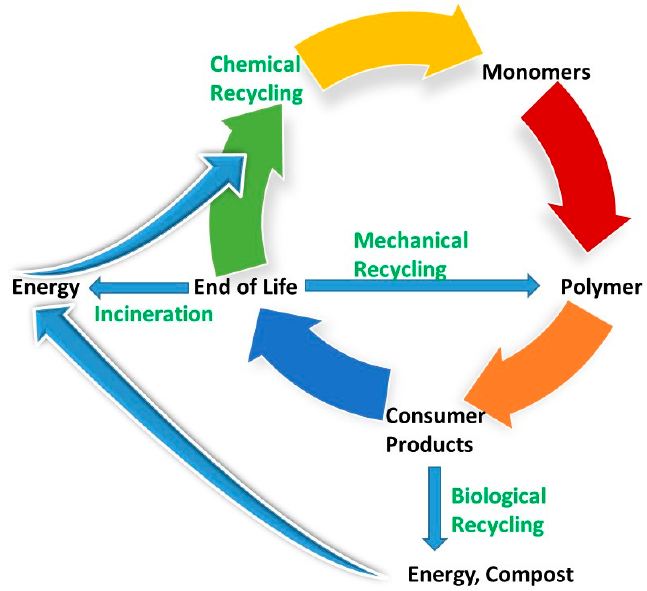
Figure 9. End-of-life options for biodegradable plastics.